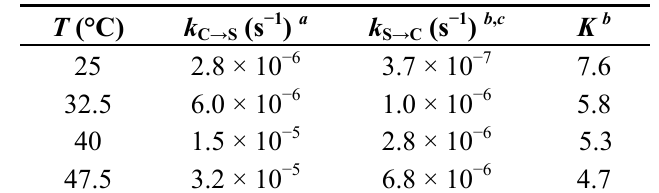
Table 1. Calculated rate constants for the switching of C to S ( k of S to C ( k ) at different temperatures, and the equilibrium constant K that represents S → C the ratio of S / C at